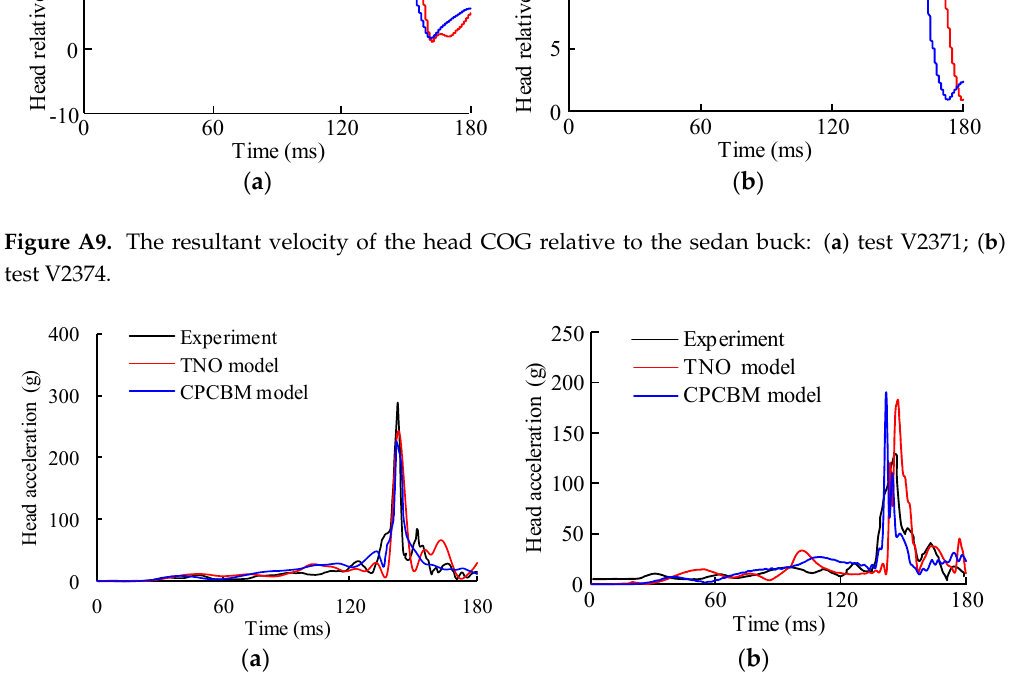
Figure A10. The resultant acceleration of the head COG: ( a ) test V2371; ( b ) test V2374.